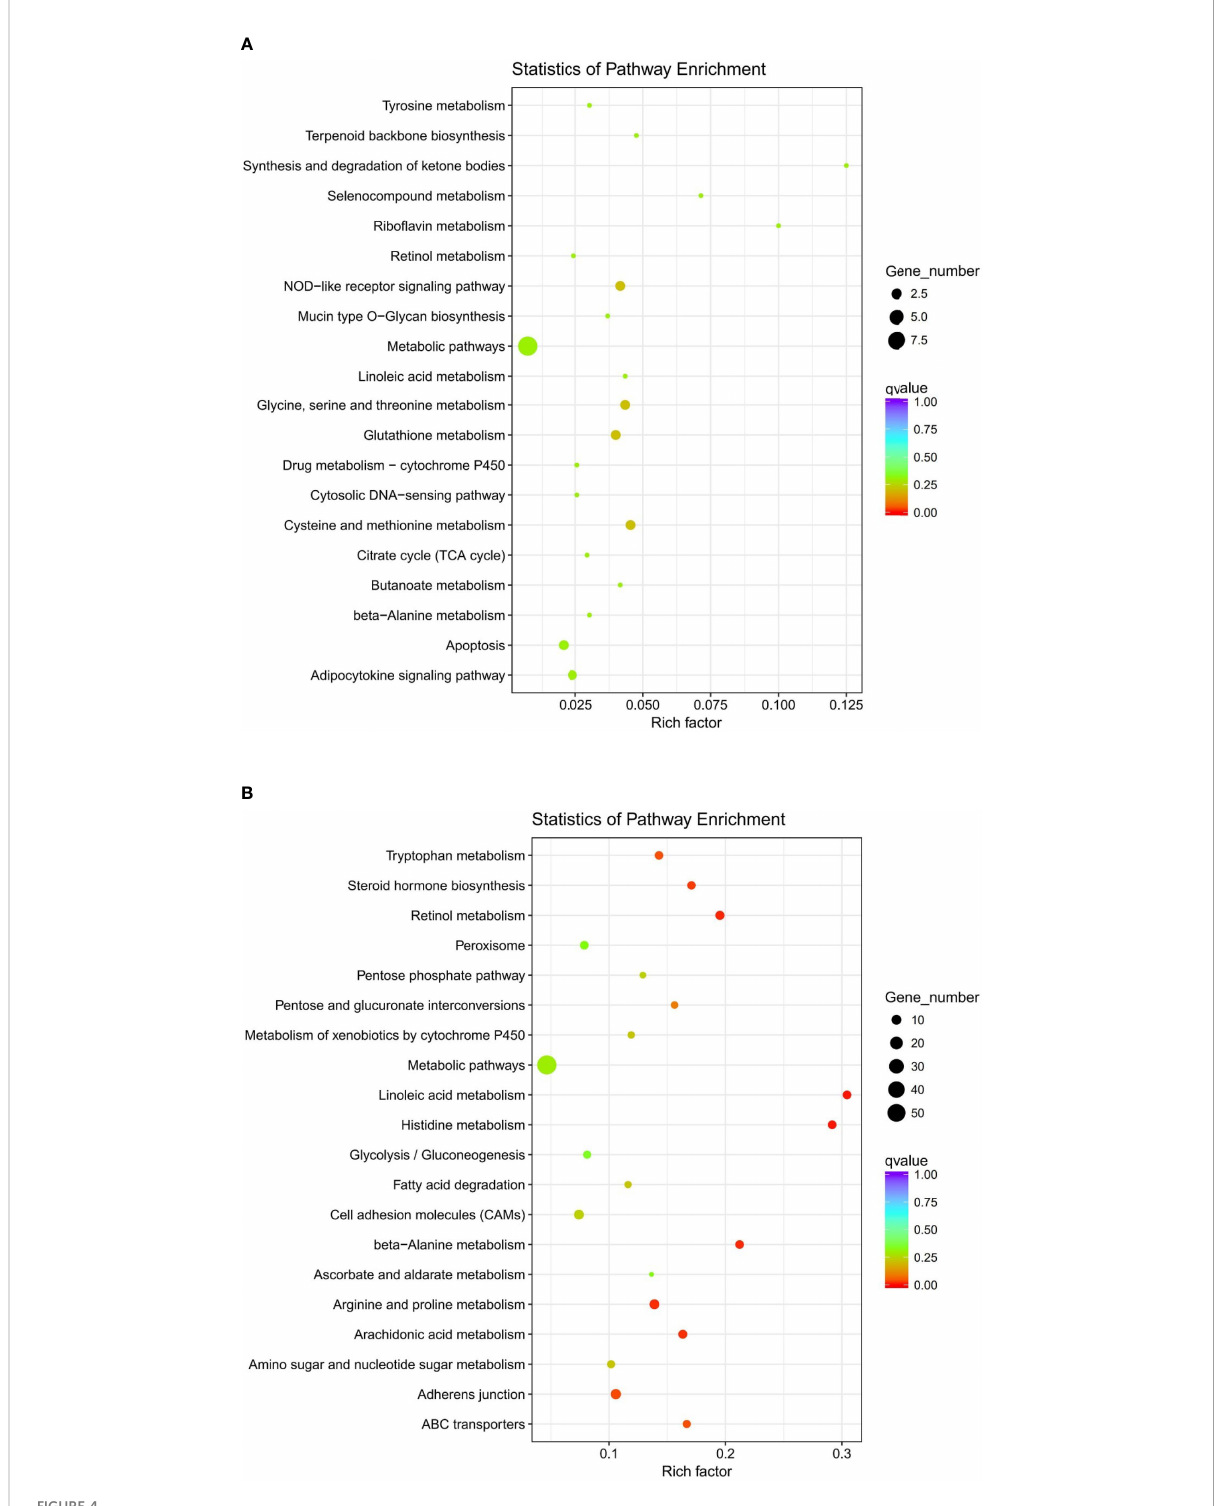
FIGURE 4 Scatter plot of Kyoto Encyclopedia of Genes and Genomes (KEGG) enrichment of differentially expressed genes (DEGs) by performing cluster analysis. (A) Enriched KEGG pathways of DEGs from subcluster_7. (B) Enriched KEGG pathways of DEGs from subcluster_1 and